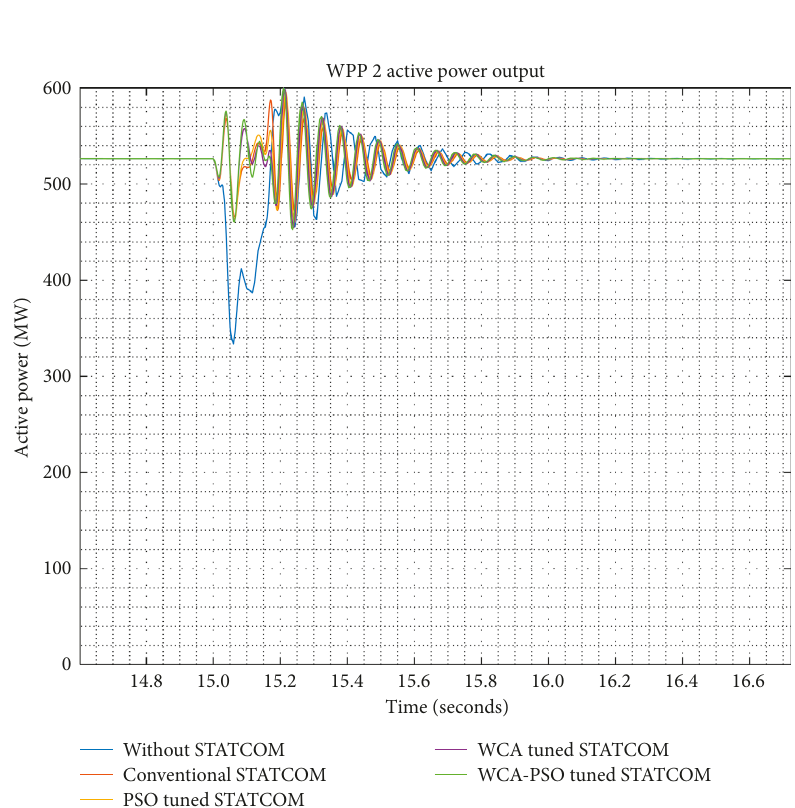
Figure 20: WPP 2 active power